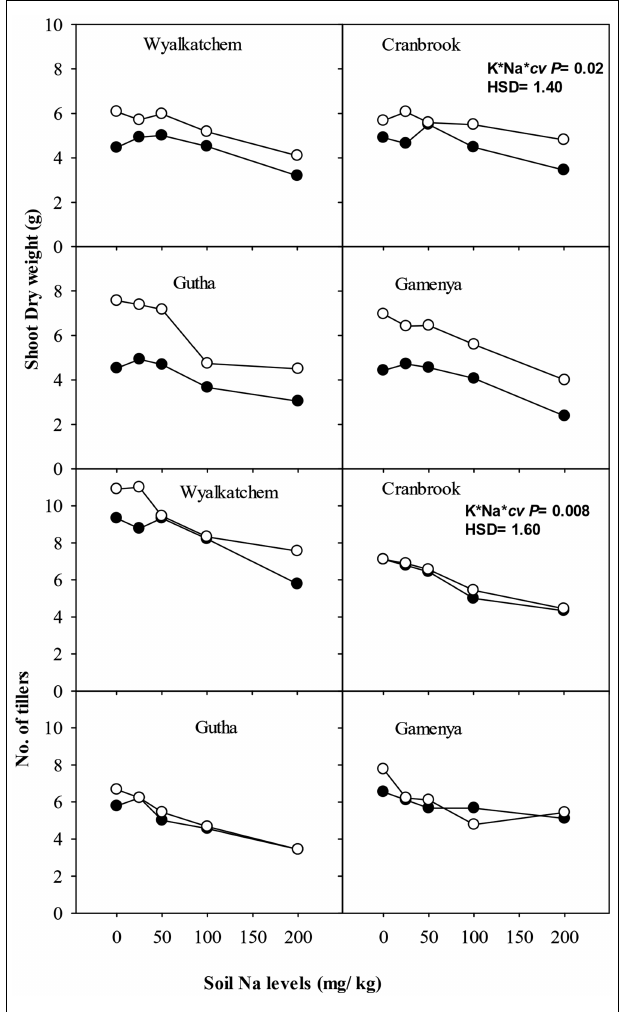
FIGURE 1 | Shoot dry weight (g/plant; upper sub-figures), and tillers/plant (lower sub-figures; n = 3) of four wheat cultivars, treated with 40 mg K/kg (closed circle) and 100 mg K/kg (open circle), and five soil Na levels (0, 25, 50, 100, and 200 mg Na/kg) for 8 weeks. See Table 1 for analysis of variance results.